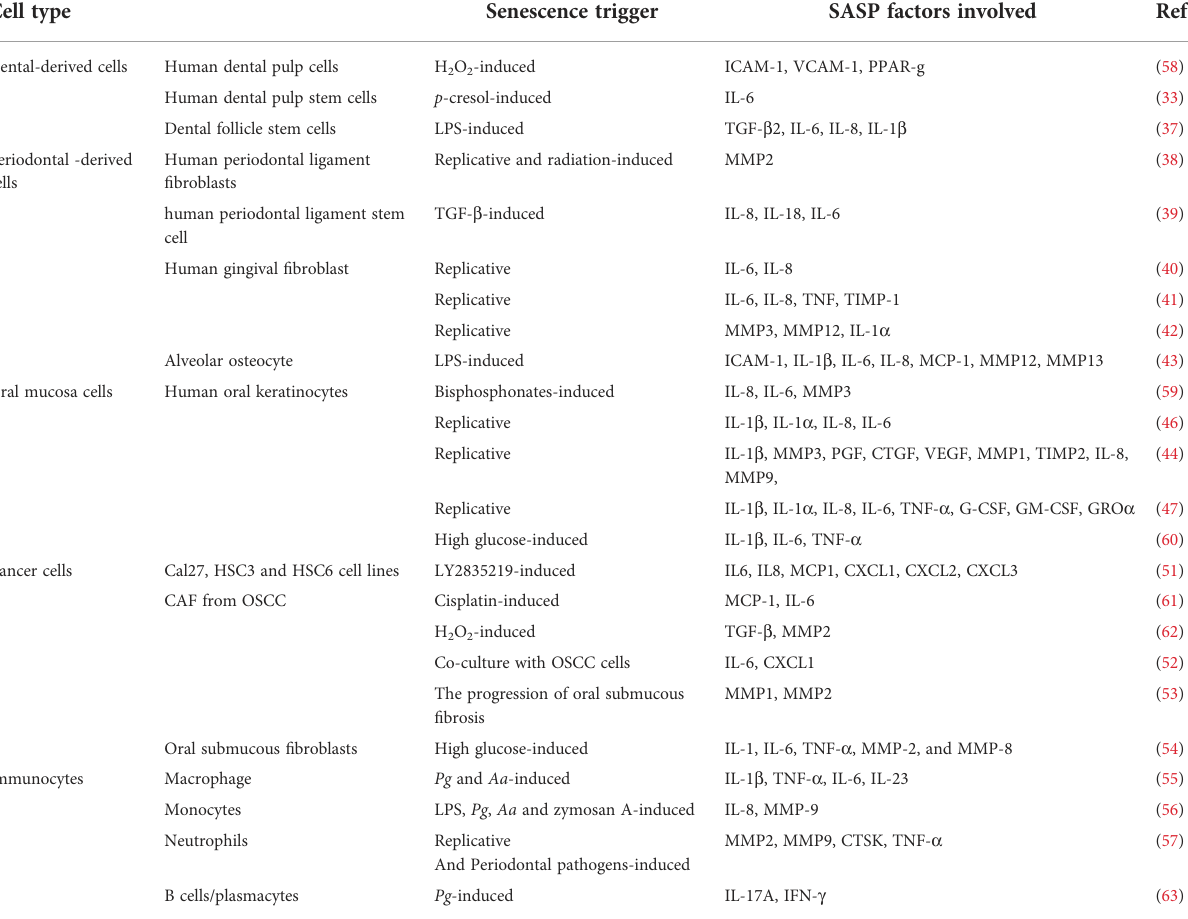
TABLE 2 Cellular senescence and SASP involved in the oral